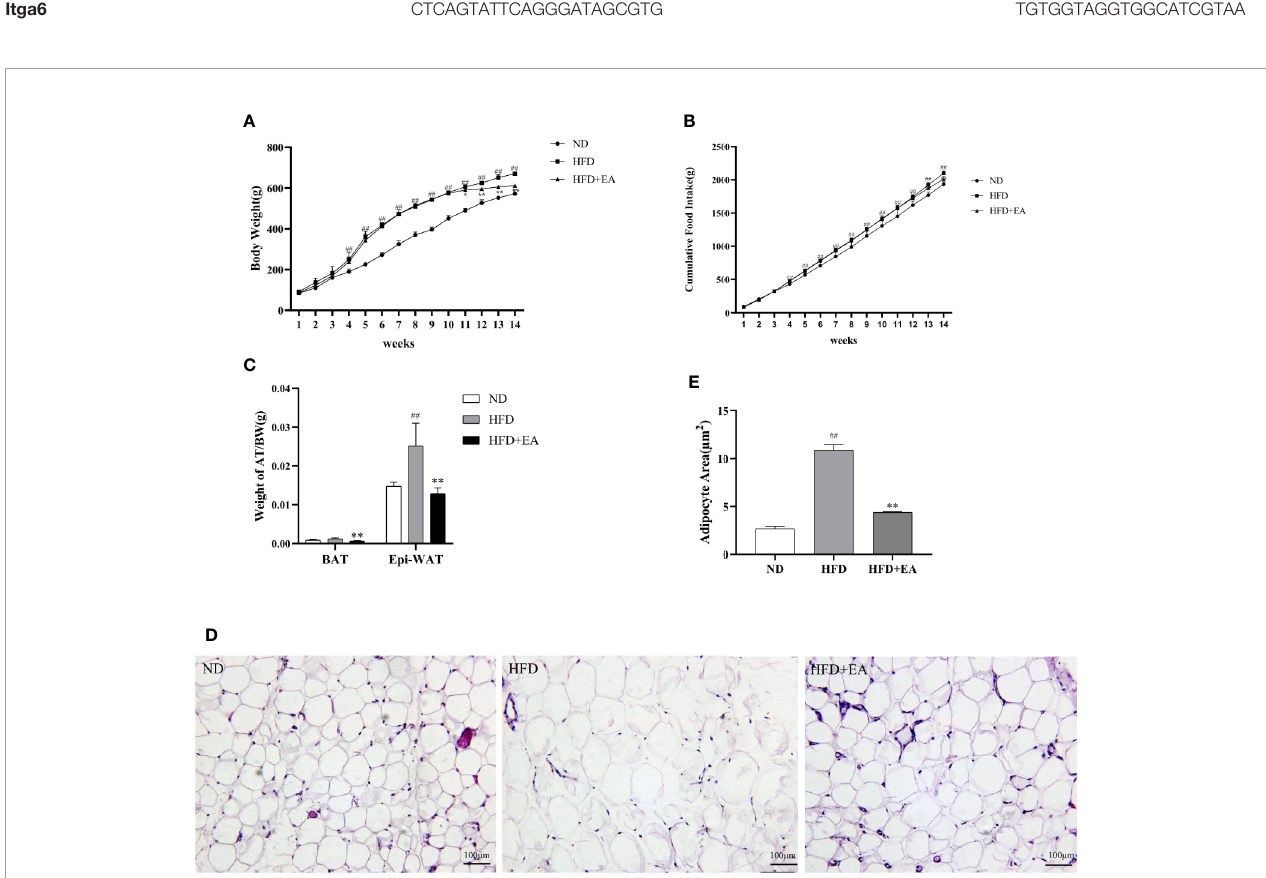
FIGURE 1 | Effect of EA on body weight, food intake, adipose weight or adipocyte area. (A, B) Body weight and cumulative food intake of normal diet (ND), high-fat diet (HFD) and high-fat diet + EA (HFD + EA) groups during 14 weeks (n = 5). (C) Epididymal white adipose tissue/body weight, brown adipose tissue/body weight in the ND group, HFD group and HFD + EA group (n = 5). (D, E) H&;E staining and adipocyte area of IWAT adipocyte size (20×, scale bar = 100 µm) in ND, HFD and HFD + EA group. Data represent the mean ± SD (n = 3). ## P < 0.01 vs. the ND group; *P < 0.01, **P < 0.05 vs. the HFD + EA group.